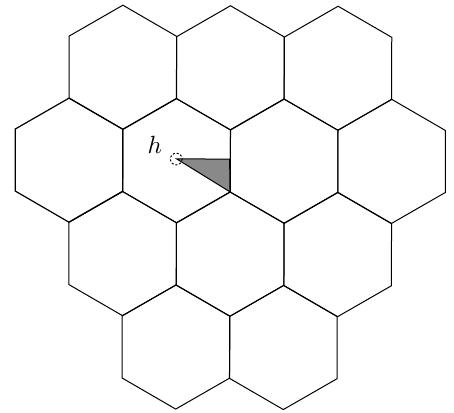
Figure 3 . A vertex in the gray area excluding the center of h can only be adjacent to vertices in these 12 hexagons.